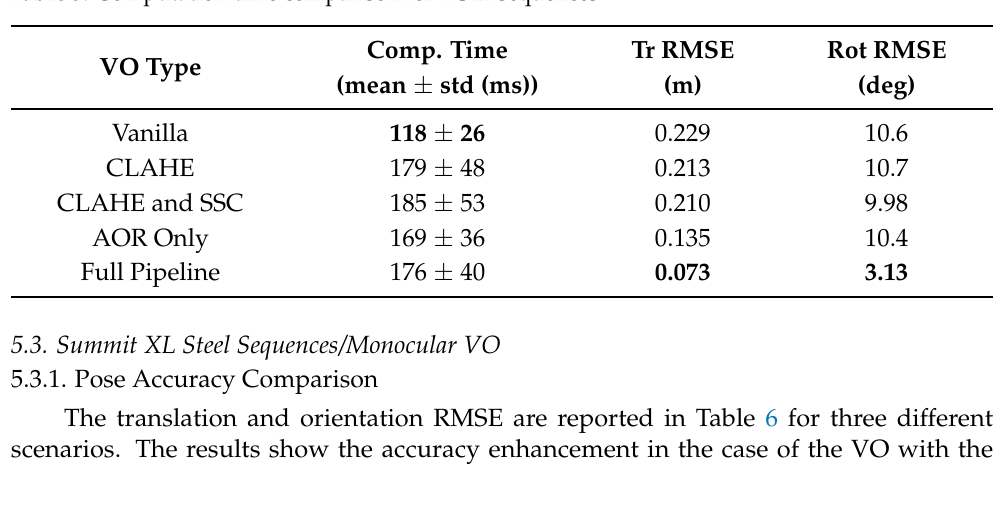
Table 5. Computation time comparison for TUM